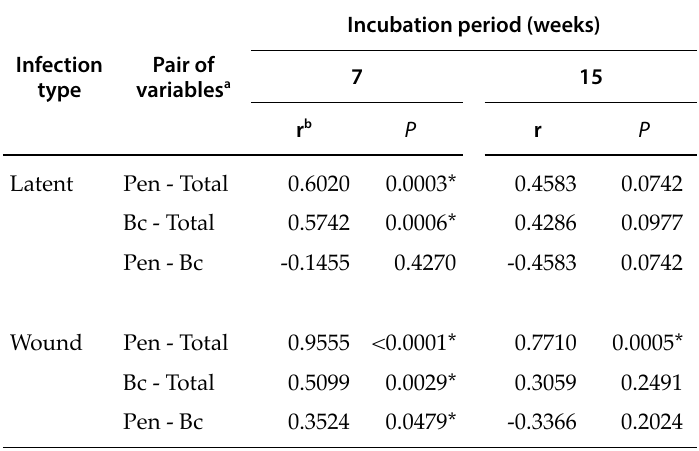
Table 1. Correlations among the incidence of postharvest diseases caused by latent and wound pathogens on pomegran